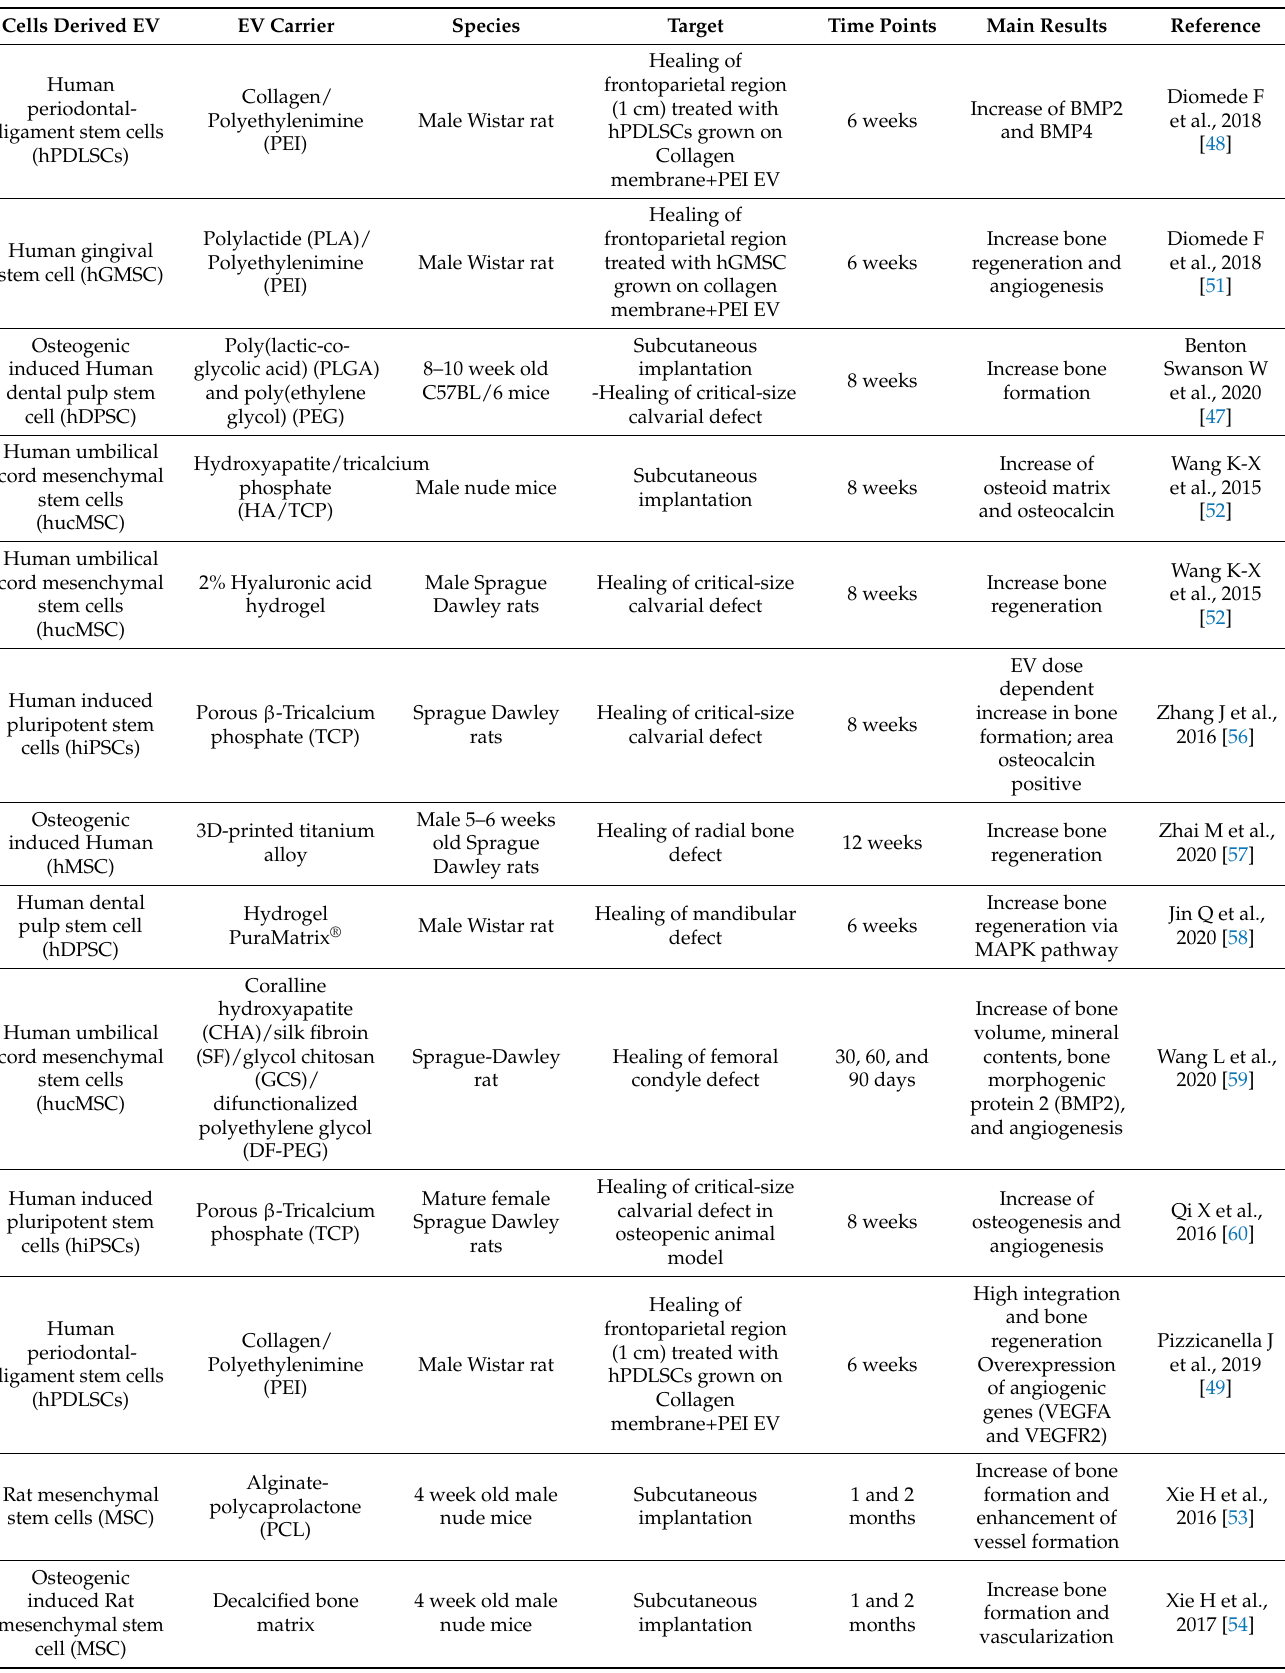
Table 2. EVs combined with scaffold used to promote bone regeneration: studies in